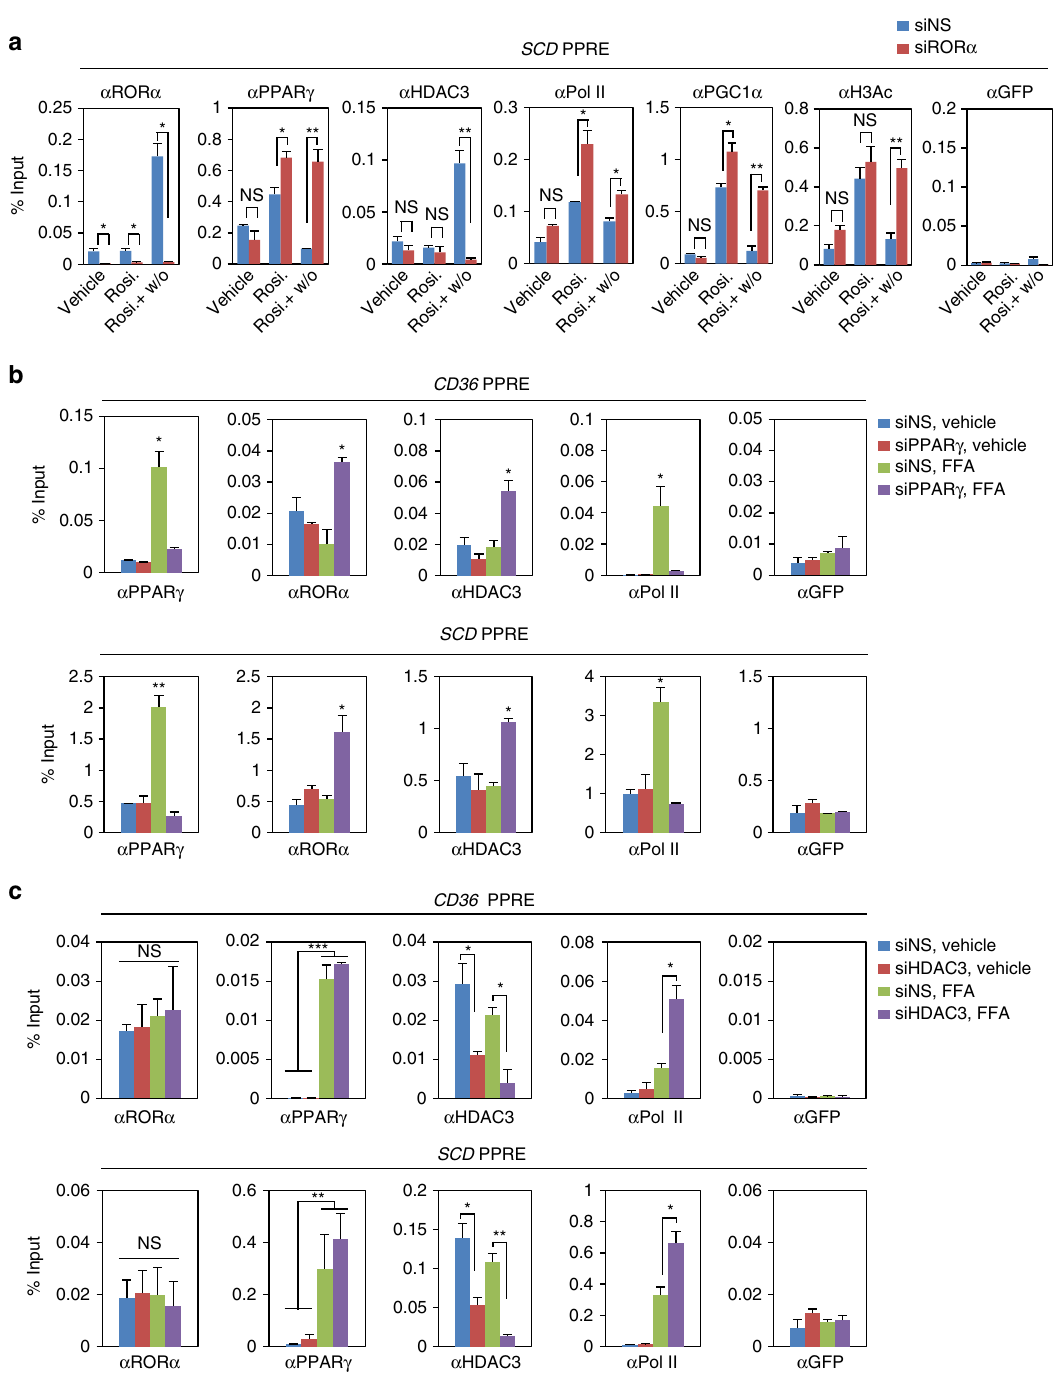
Fig. 6 Recruitment of ROR α and PPAR γ to the PPAR γ target gene promoters are mutually exclusive. a ChIP assays were performed in the absence or presence of ROR α on SCD promoters in Hep3B cells with or without Rosiglitazone (20 μ M) treatment for 24 h and washout 8 h. Promoter occupancy of ROR α , PPAR γ , HDAC3, Pol II, PGC1 α , H3Ac and GFP was analyzed. Statistical analysis was performed using Student ’ s unpaired t -test. * P < 0.05, ** P < 0.01, NS, non-signi fi cant. b , c ChIP assays were performed in the absence or presence of PPAR γ b /HDAC3 c on the CD36 and SCD promoters in Hep3B cells with or without free fatty acid (free fatty acid: Oleic acid 200 μ M and Palmitic acid 100 μ M) treatment for 24 h. Promoter occupancy of PPAR γ , ROR α , HDAC3, Pol II and GFP was analyzed. Data expressed as mean ± s.e.m. Statistical analysis was performed using one-way ANOVA. * P < 0.05, ** P < 0.01, *** P < 0.001. Data expressed as mean ±